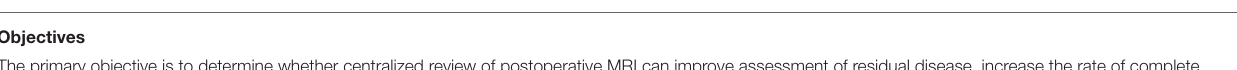
TABLE 2 | Synthetic presentation of objectives and endpoints of the study for the staging, and different strata.